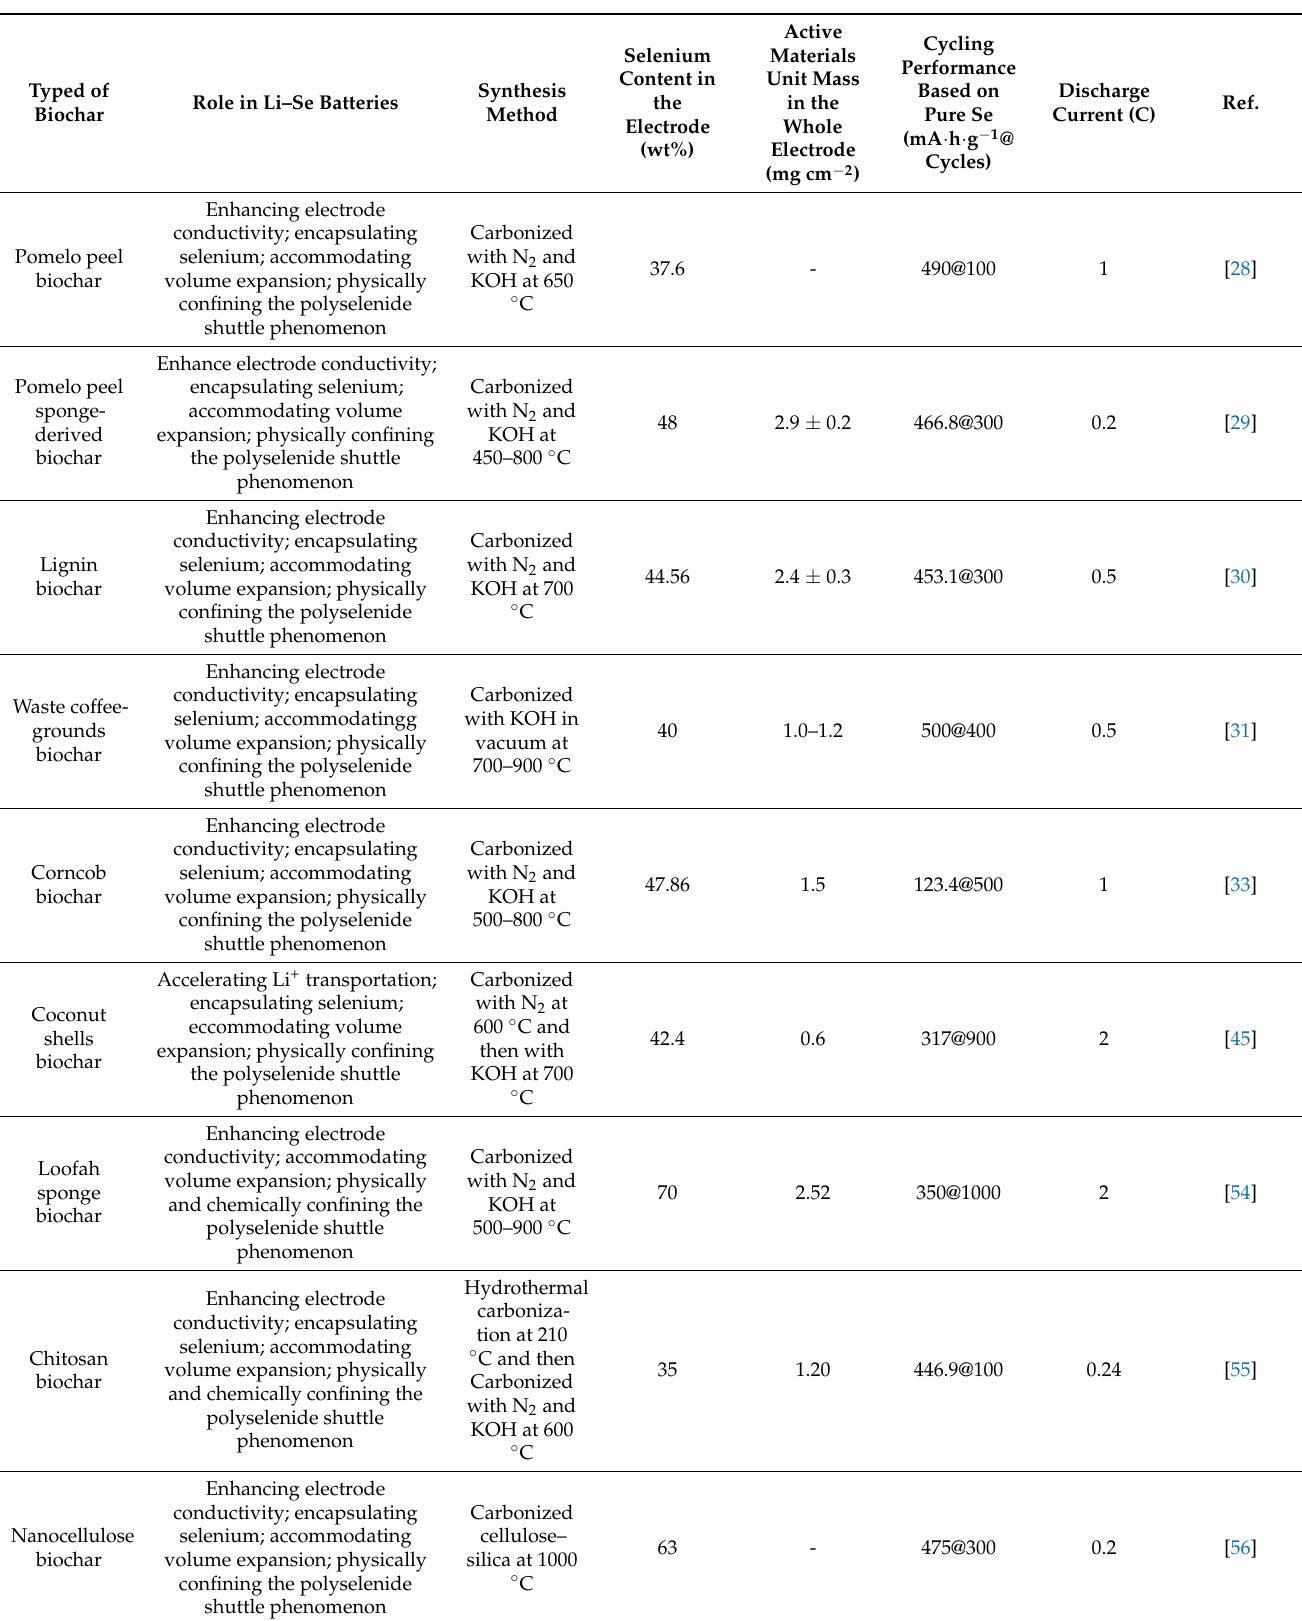
Table 1. Biomass-derived carbon material utilization in Li–Se